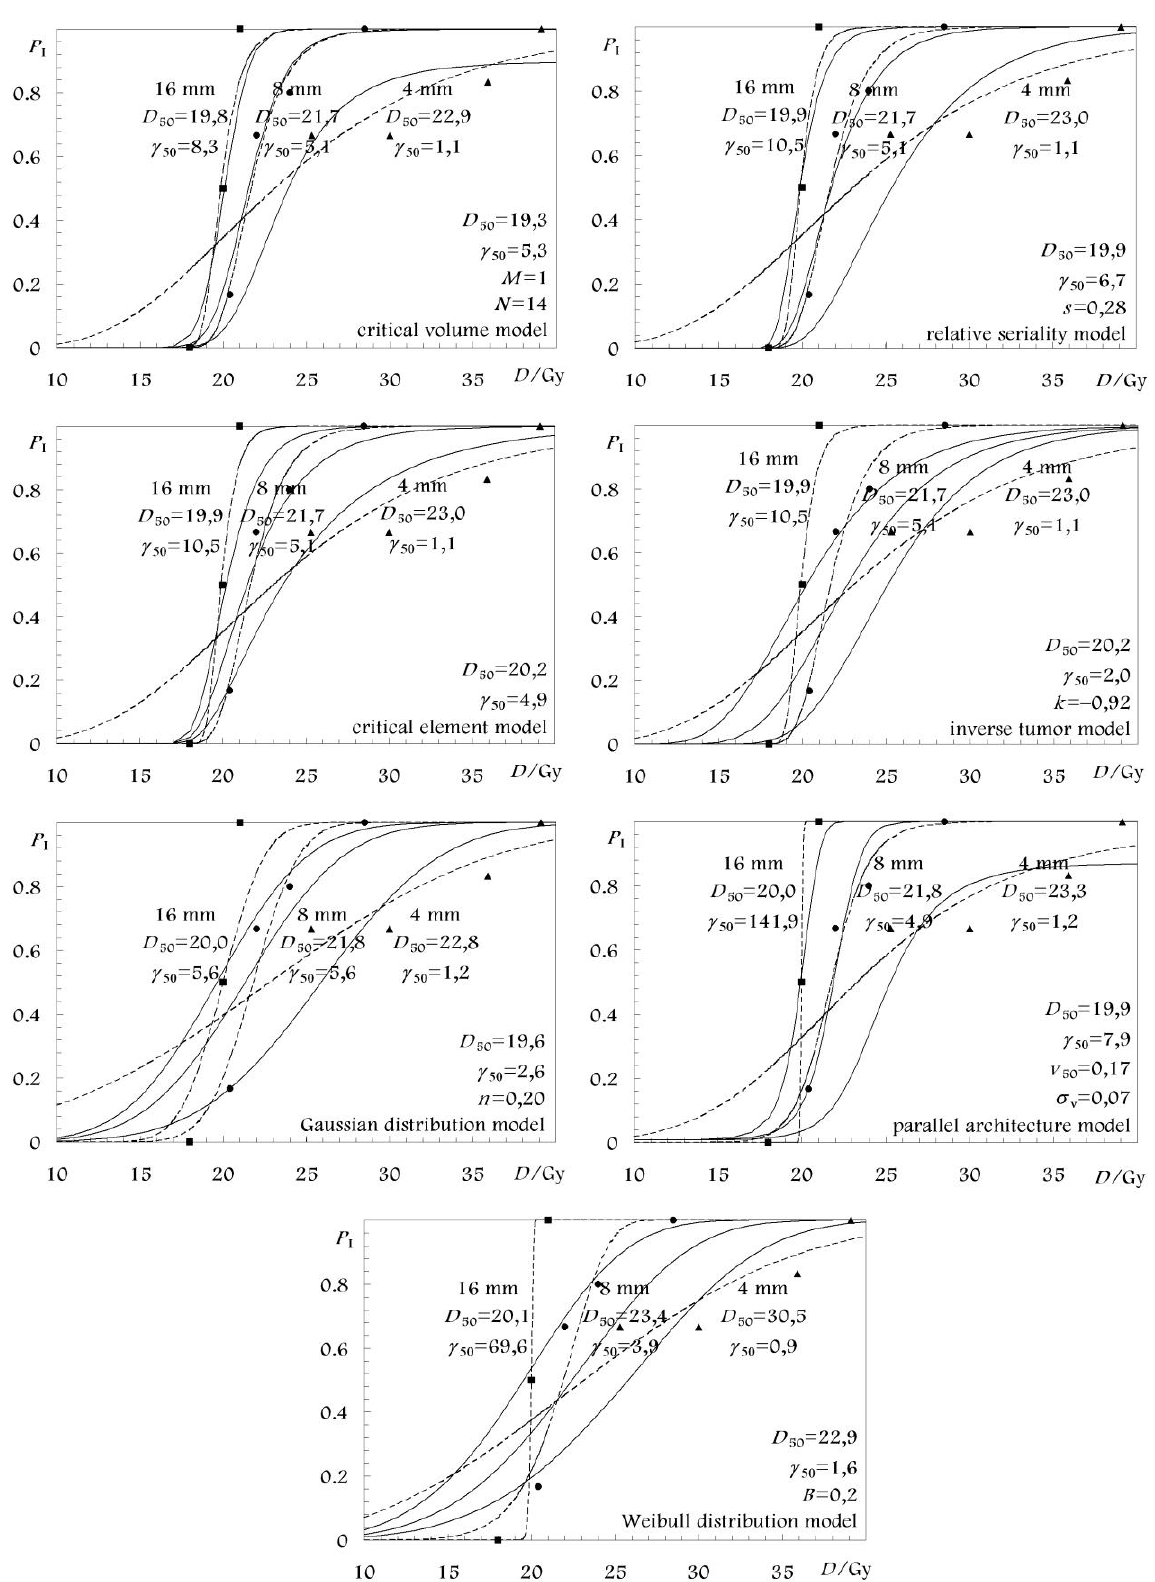
Figure 3. Volume and dose-response curves for vascular damage of different lengths of rat cervical spinal cord. The solid lines give the combined best fitting. The dashed lines have been fitted to each of the irradiated spinal cord segment lengths separately, i.e. , without any volume